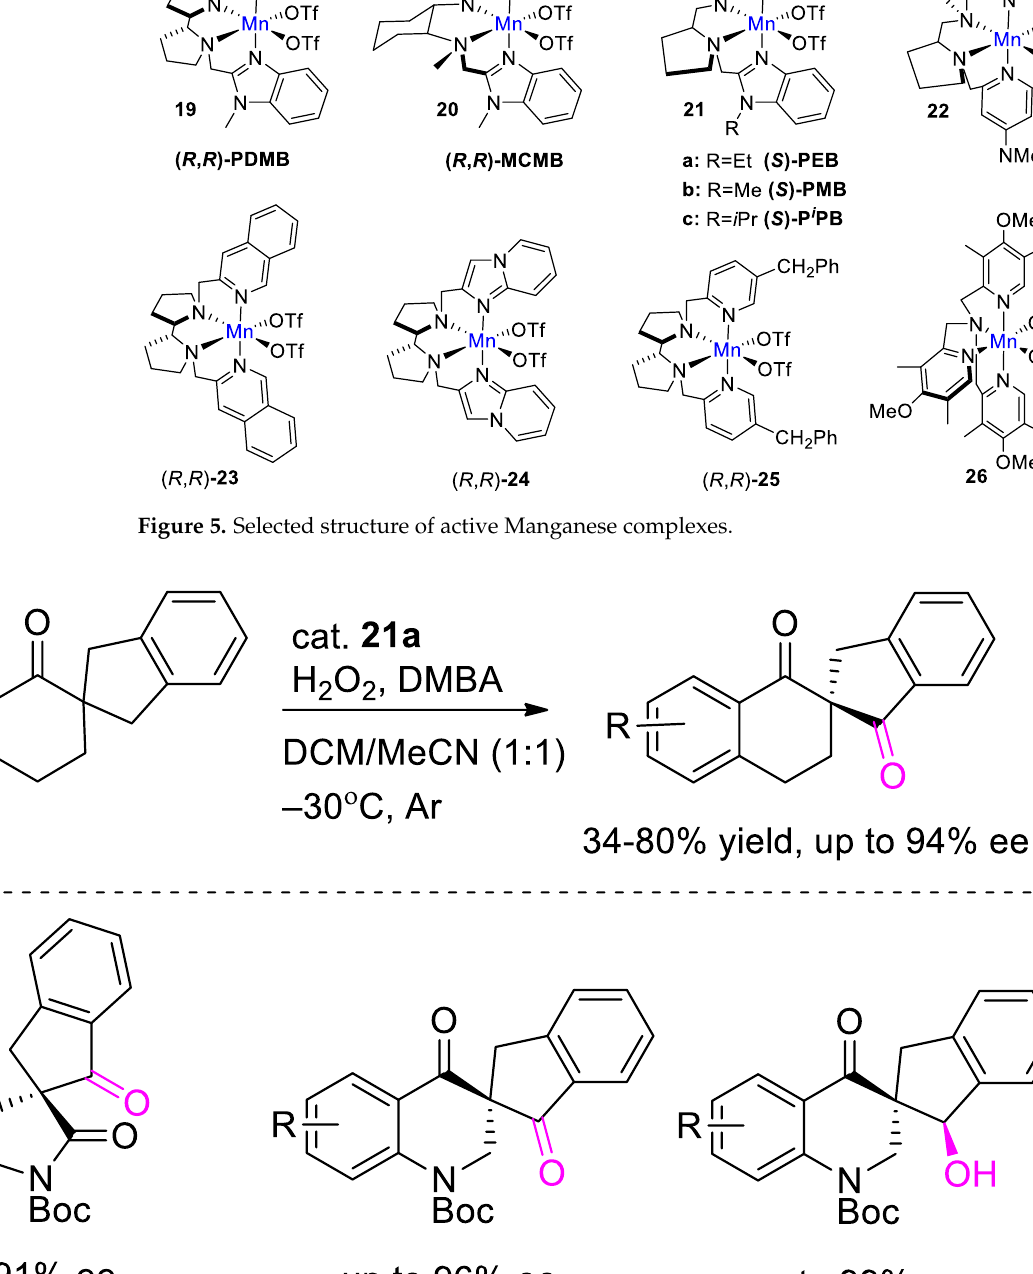
Figure 5. Selected structure of active Manganese